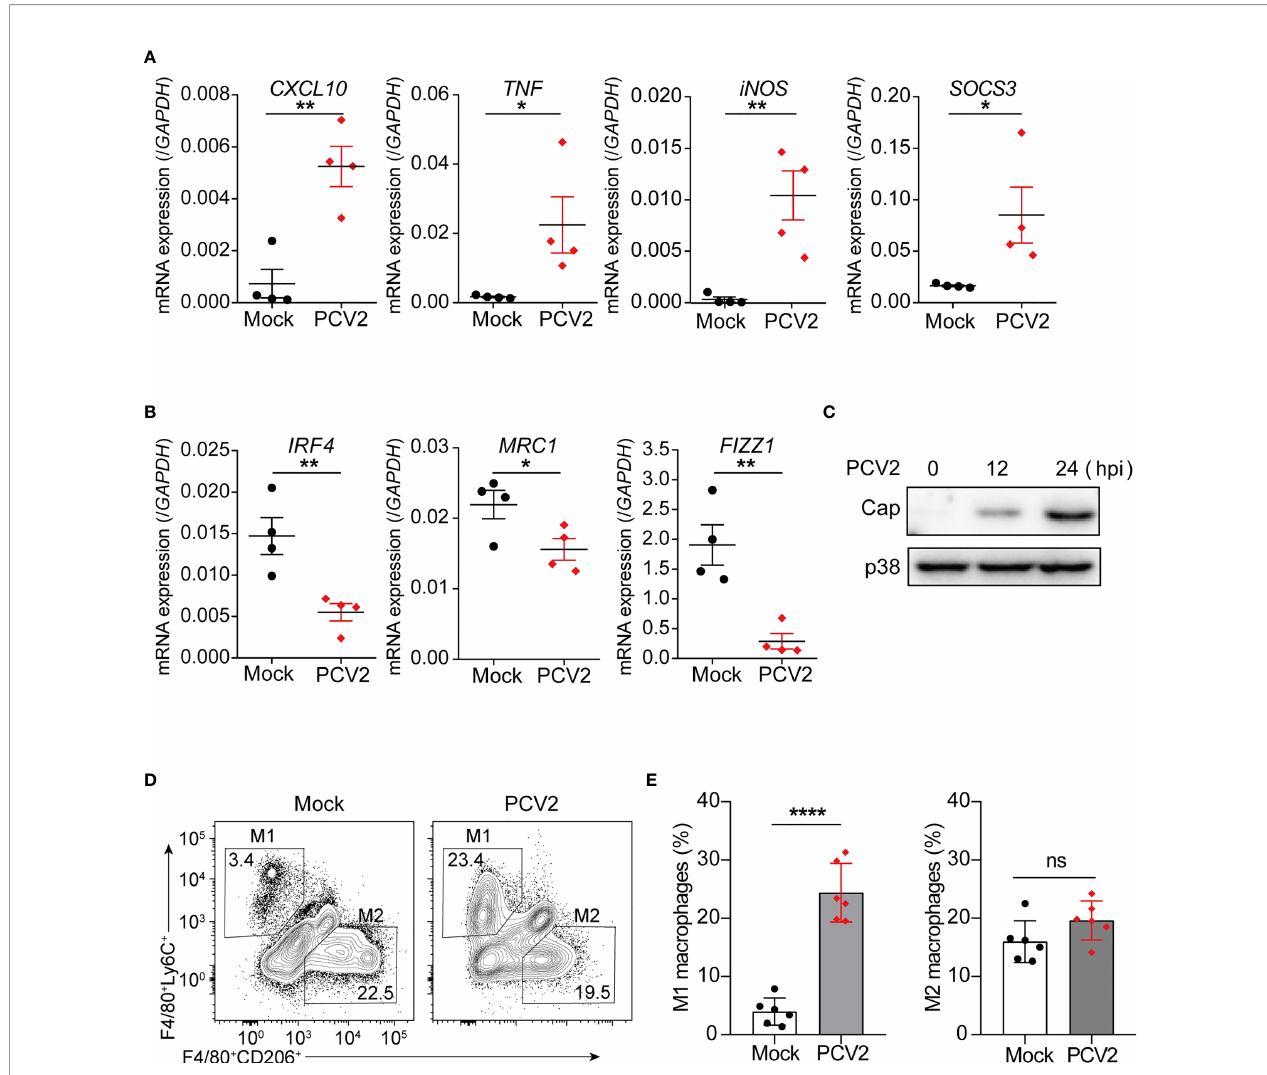
FIGURE 2 | PCV2 infection promotes M1 macrophage polarization in vivo . (A, B) qPCR analysis of mRNA expression of M1-associated genes (A) and M2- associated genes (B) in peritoneal cells from mice (n=4) were either mock-infected or infected with PCV2 (5×10 5 pfu per mouse, the same dose below) for 12 h. (C) Immunoblot analysis expression of PCV2 Cap in peritoneal cells from mice infected with PCV2 for indicated periods. (D, E) Flow cytometry analysis of peritoneal exudates from mock mice or PCV2-infected mice for 24 h. Numbers in top left gated population indicate percent F4/80 + Ly6C hi cells (M1-polarized macrophages) and numbers in lower right gated population indicate percent F4/80 + CD206 hi cells (M2-polarized macrophages). Right, cumulative quanti fi cation of M1 and M2 macrophages as at left panels. Each symbol represents an individual mouse. Data are from one experiment ( A – E ; mean + s.d of n=4 mice in A and B or n=6 mice in E ) * P < 0.05; ** P < 0.01; **** P < 0.0001 (Student ’ s t test). ns, not signi fi